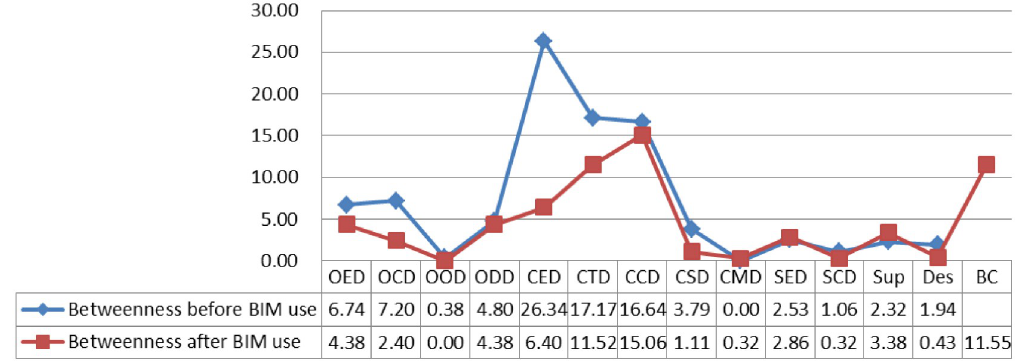
Fig 5. The betweenness centrality in project communication networks.